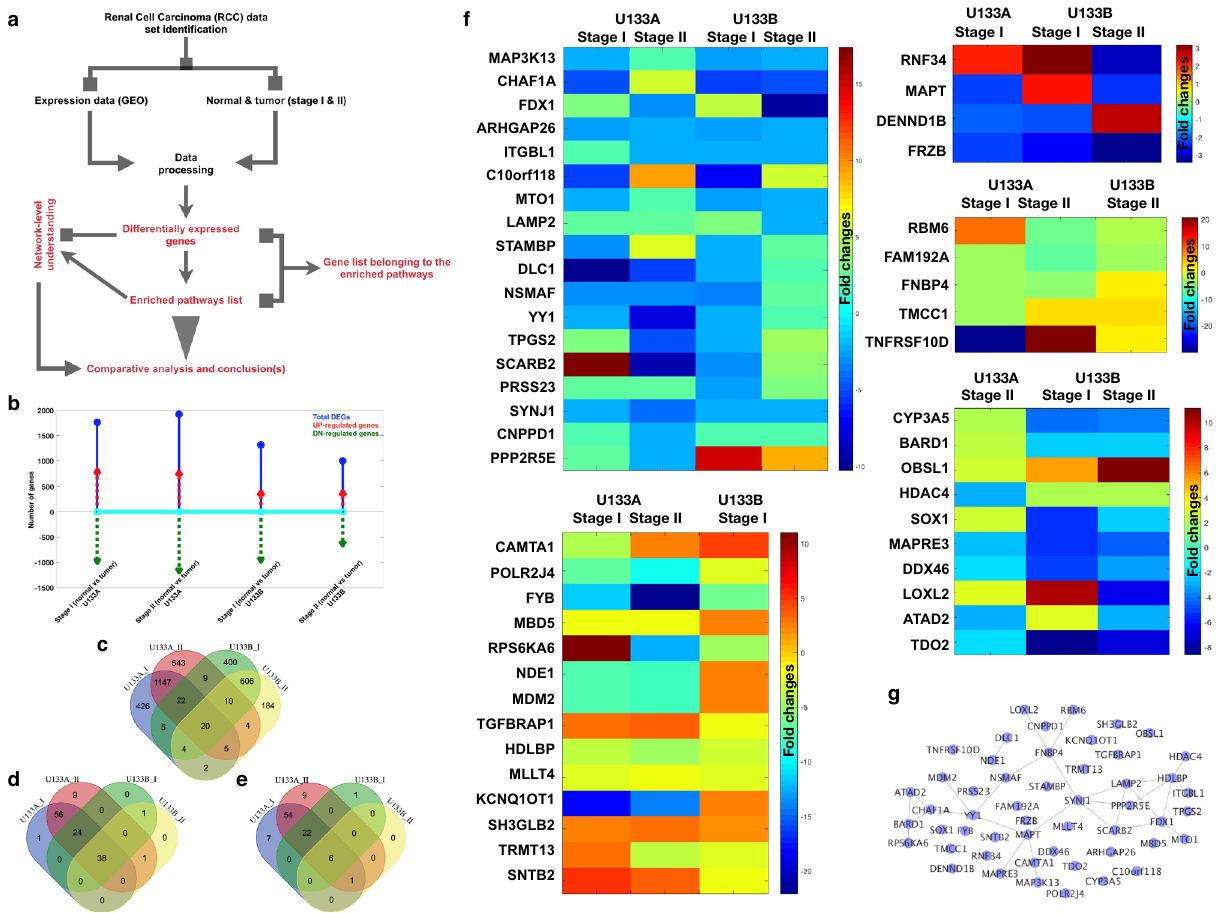
Figure 1. Gene expression profiling. ( a ) Workflow: from raw dataset to analysis. ( b ) Number of DEGs, up- and down-regulated genes. ( c ) Venn diagram to display the DEGs. ( d ) Venn diagram for enriched pathways for the DEGs (p-value ≤ 0.05). ( e ) Venn diagram for enriched pathways for the DEGs (p-value ≤ 0.001). ( f ) Common genes between different stages and the array chips (U133A and U133B) with their fold changes. ( g ) Mapped network for all the genes in ( f ). For venn diagram plotting, freely available webserver (http:// bioin forma tics. psb. ugent. be/ webto ols/ Venn/) was used and the heatmaps and bar plot were generated by using MATLAB 2017b by using imagesc and plot commands,